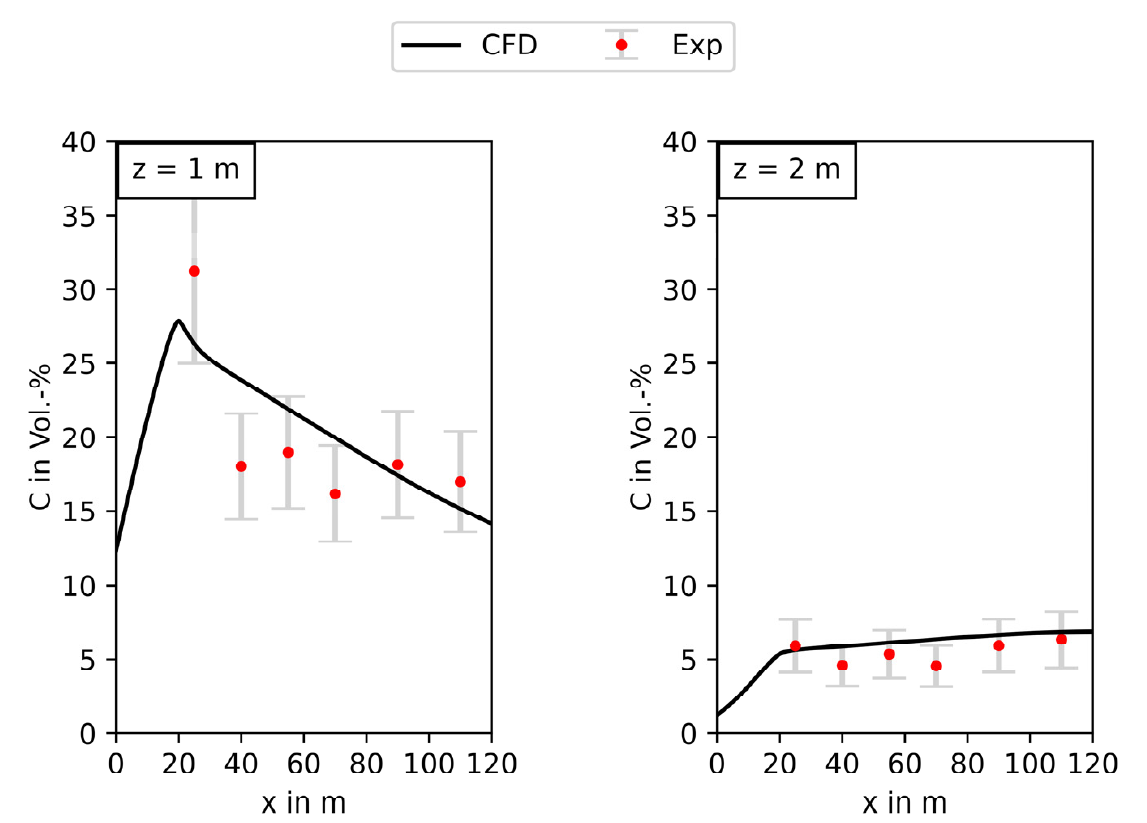
Figure 9. Heavy gas cloud centerline profiles of the concentration over the distance to the source in 1 m height over ground ( left ) and 2 m height over ground ( right ).